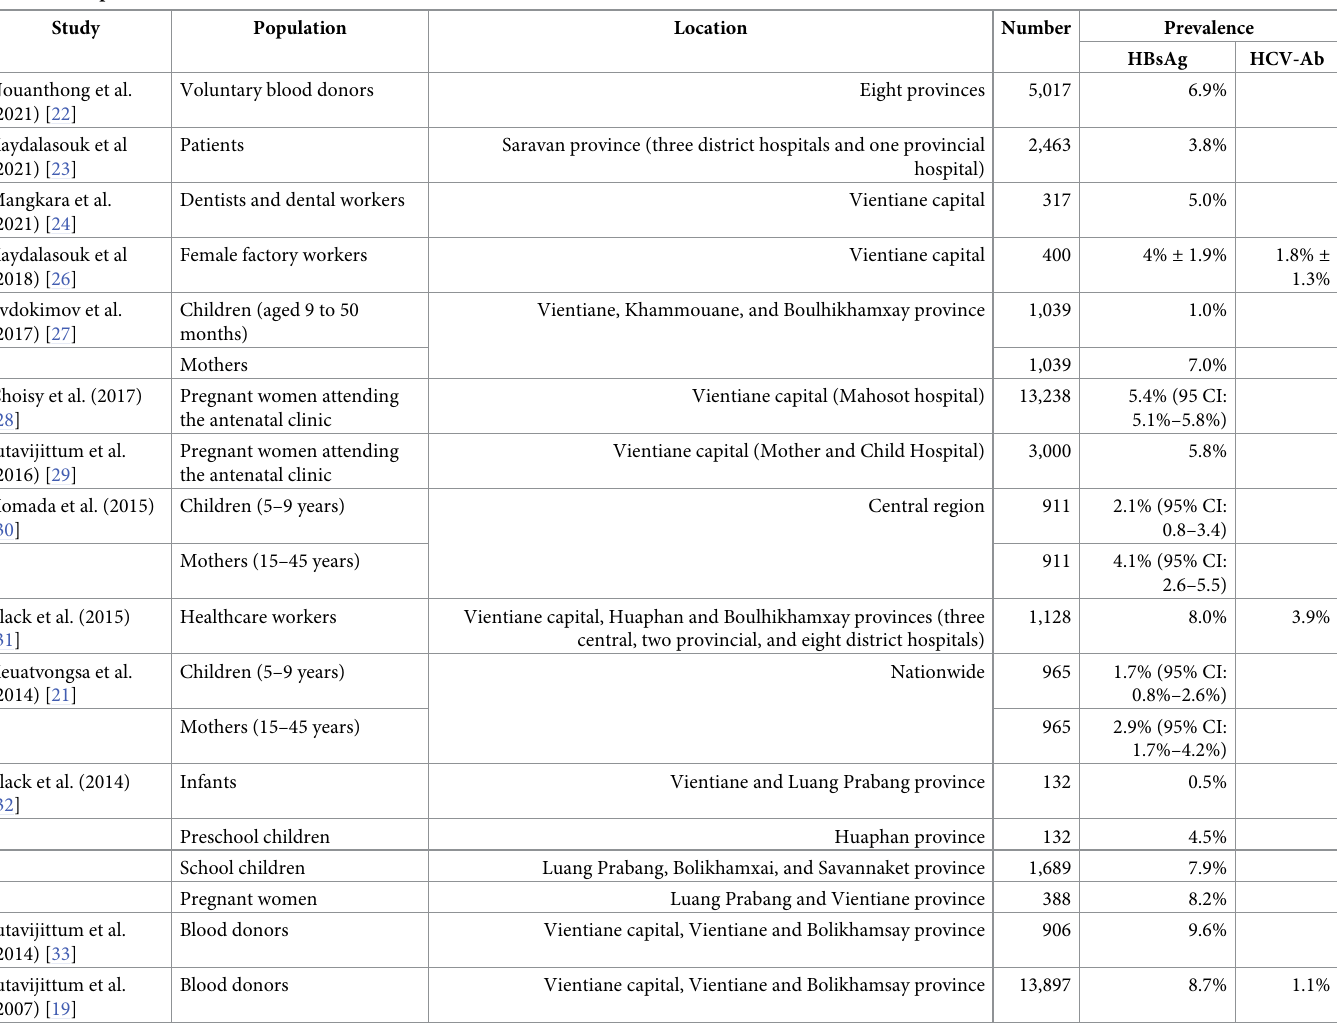
Table 4. Seroprevalence studies on HBV and HCV infection in Lao